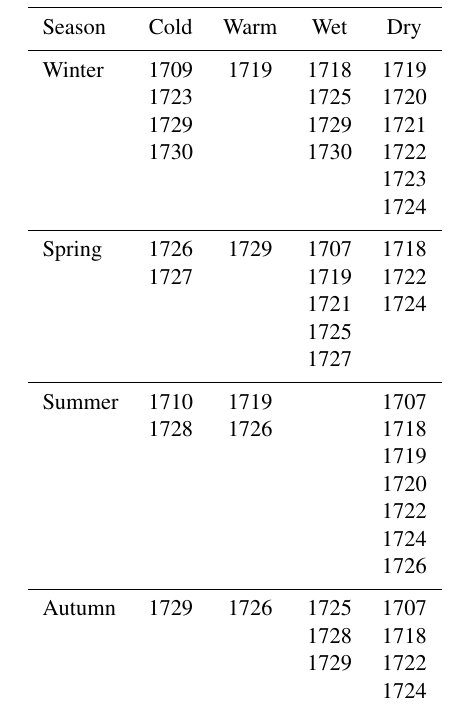
Table 1. Extreme seasons in Granada from 1706 to 1730 (Rodrigo, 2018a, NavarreteData.xlsx, http://hdl.handle.net/10835/6248,